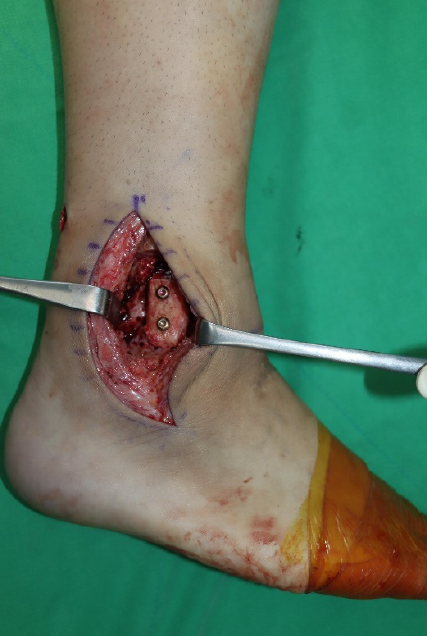
Figure 8. The lateral half of the resected fibula was fixed by four cancellous screws in its original anatomical position as a natural lateral bony plate.